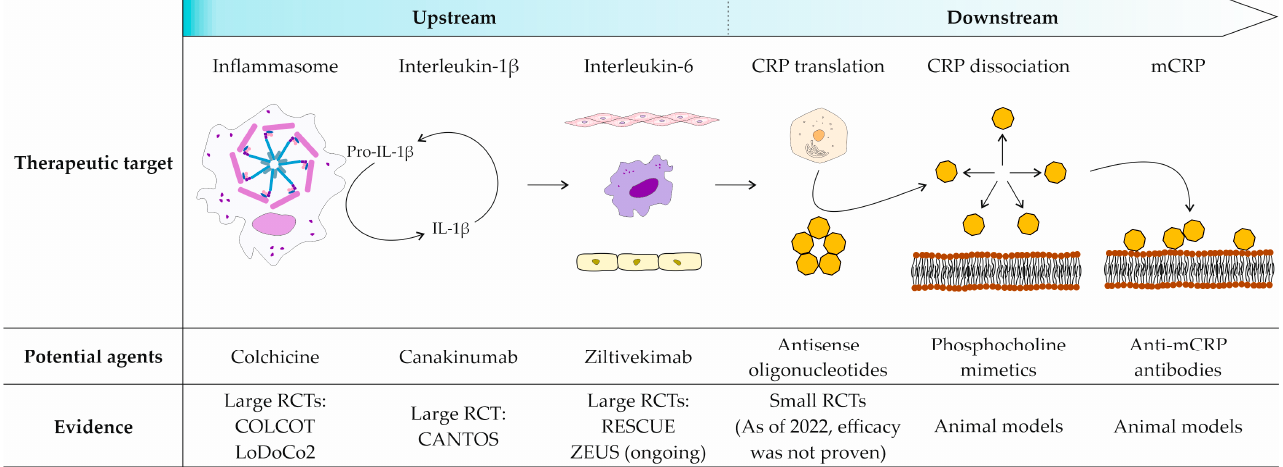
Figure 2. Anti-inflammatory agents targeting the NLRP3 inflammasome and IL-1 β /IL-6/CRP axis. Upstream agents targeting the NLRP3 inflammasome, interleukin (IL)-1 β , and IL-6 reduce the rate of major adverse cardiovascular events, according to large RCTs. Downstream agents target translation of pCRP in the liver, CRP dissociation, and mCRP. Studies on these agents are limited to animal models and small RCTs. CRP, C-reactive protein; mCRP, monomeric C-reactive protein; pCRP, pentameric C-reactive protein; RCTs, randomized clinical trials.